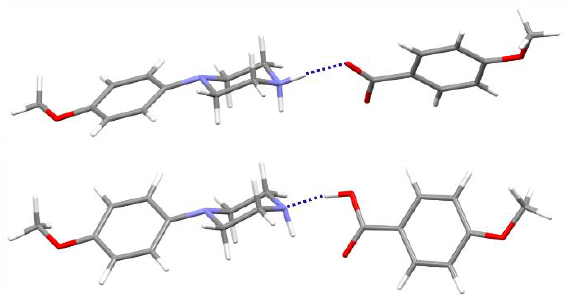
Figure 6. The cation-anion pair linked by the N — H···O hydrogen from the analyzed salt (above) and corresponding neutral pair with the O — H···N interactions optimized in the gas-phase (below); components of structure (II) are taken as representatives.